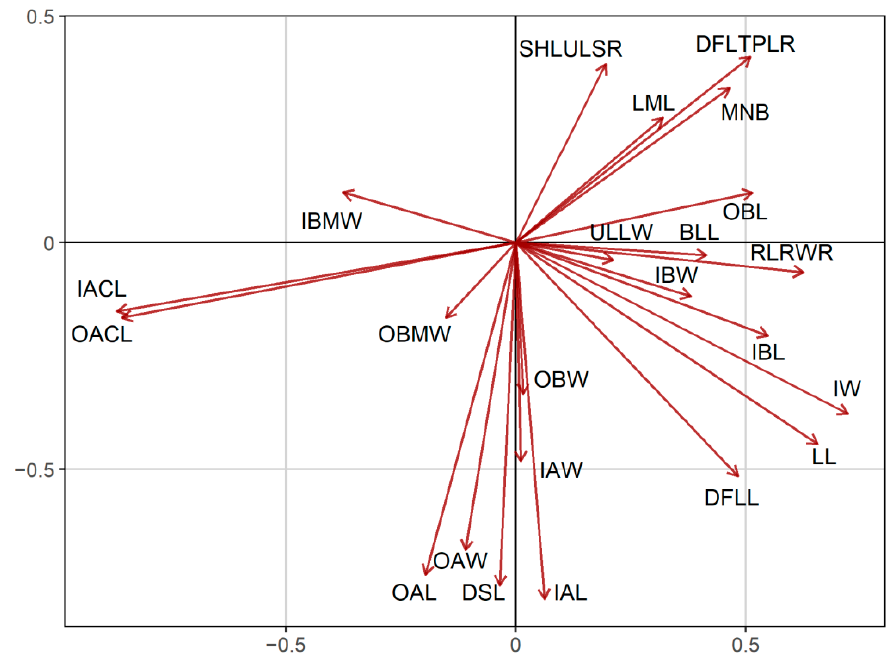
Figure 3. Relative contribution of the morphological characters to the PCA of Figure 1.